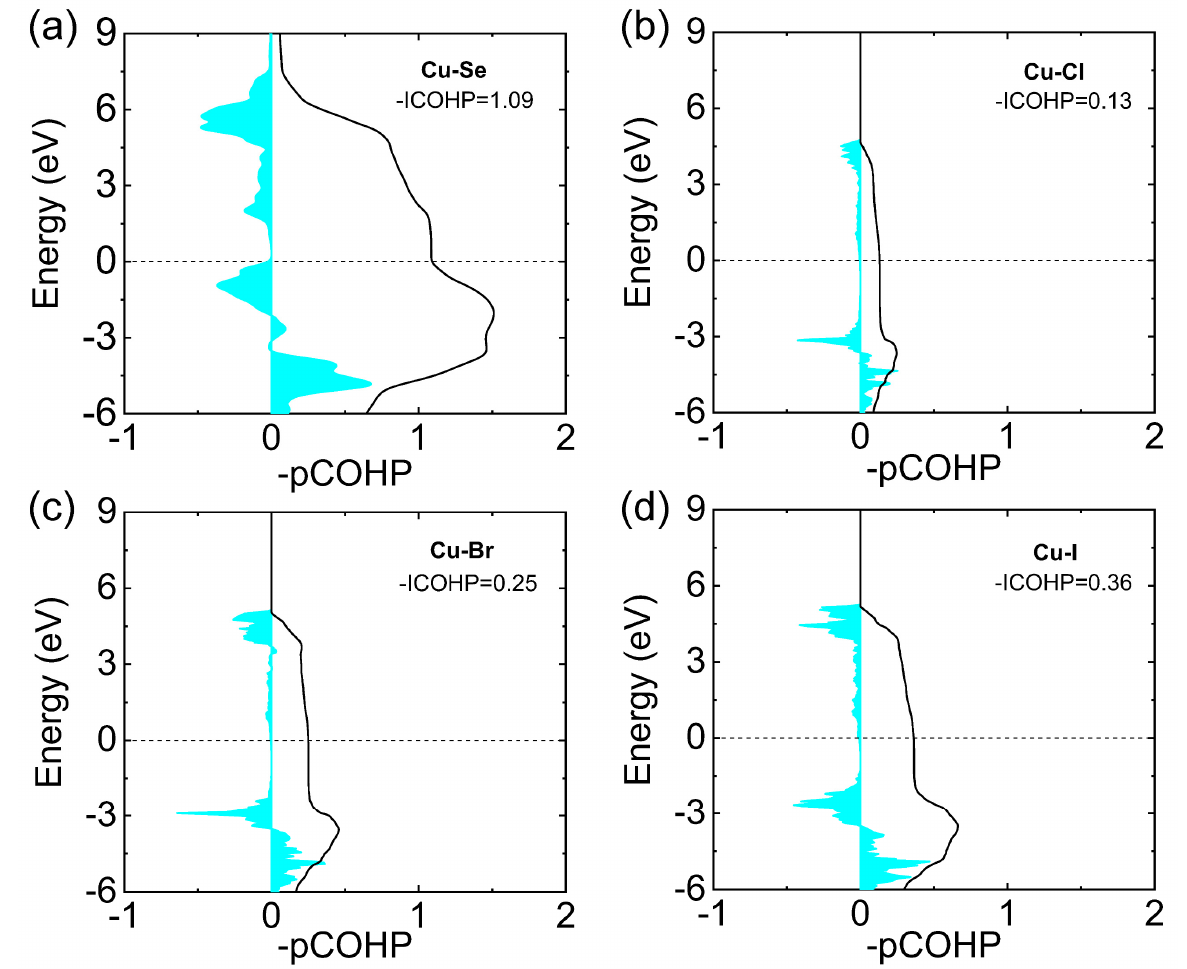
Figure 5. The energy integrated Crystal Orbital Hamiltonian Population (ICOHP) values for ( a ) Cu–Se bonding in BiCuSeO, ( b ) Cu–Cl bonding in Bi 1.04 Cu 1.05 Se 0.99 Cl 0.01 O, ( c ) Cu–Br bonding in Bi 1.04 Cu 1.05 Se 0.99 Br 0.01 O and ( d ) Cu–I bonding in Bi 1.04 Cu 1.05 Se 0.99 I 0.01 O. Data in ( a – d ) were adopted from Reference [66]. Copyright 2019, Elsevier Ltd and Techna Group